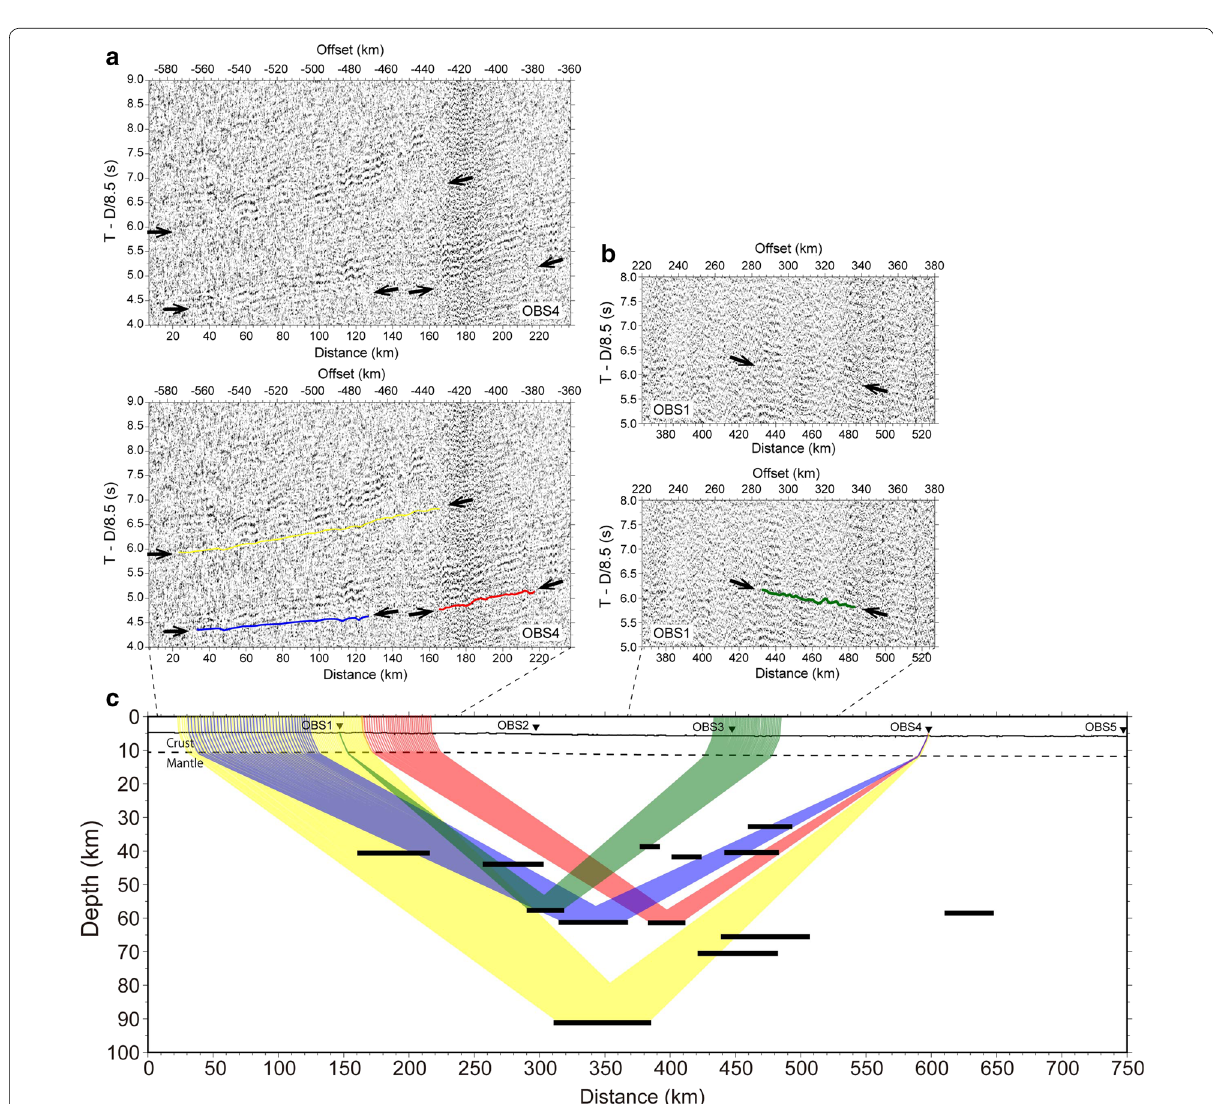
Fig. 10 Close-ups of parts of the a OBS4 and b OBS1 record sections (see Fig. 6a). Arrows indicate wide-angle reflection phases (DRs) at large offsets. The lower panels show the travel times calculated by 2-D ray tracing superimposed on the sections shown in the upper panels. Reduction velocity is 8.5 km/s. c Ray diagram for each DR. Black bars indicate reflection